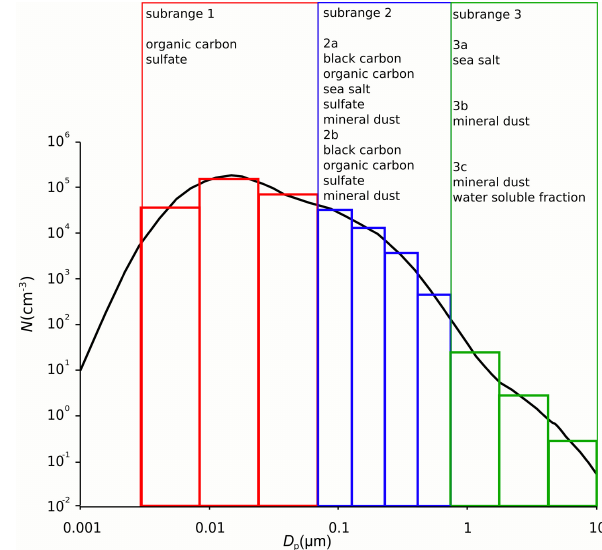
Figure 2. Schematic of sectional distribution of aerosol size bins and the chemical components in the bins (taken from Kokkola et al.,